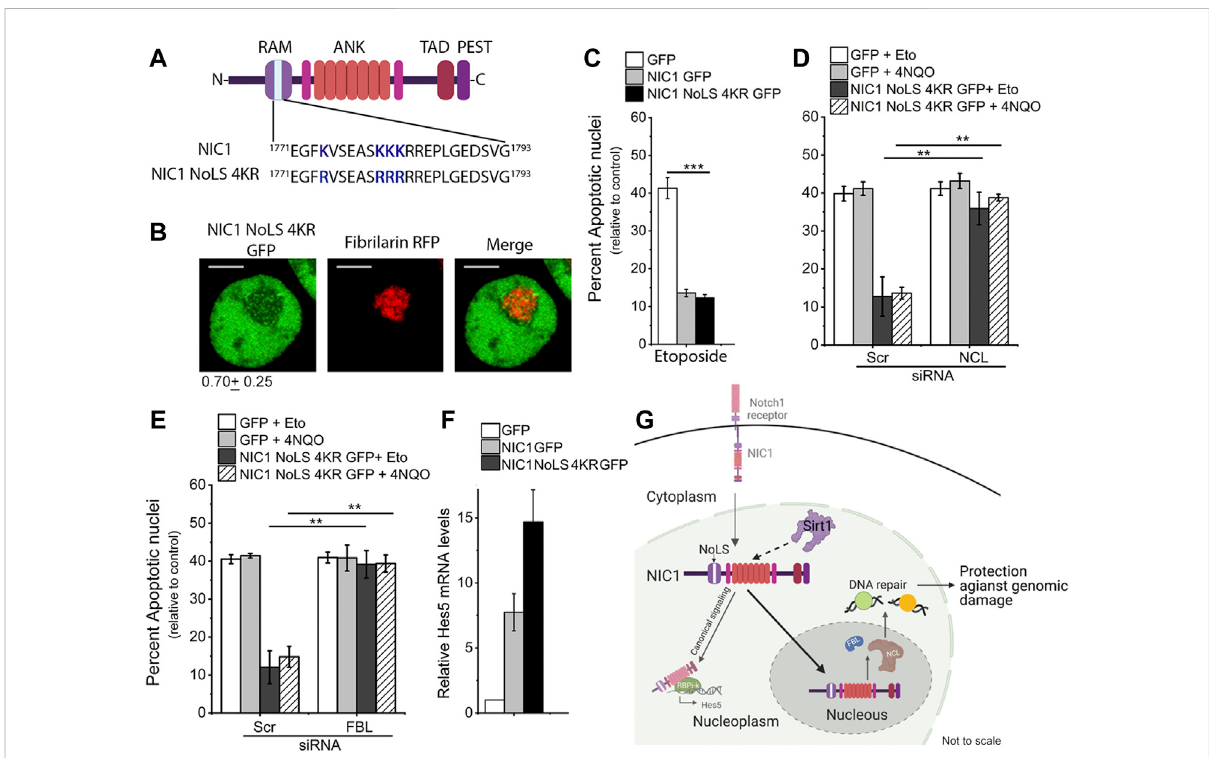
FIGURE 4 Lysine (K)to arginine (R)mutationinNIC1promoteslocalization to thenucleolus. (A) Schematicshowinglysine (K)residues mutated toarginine (R) in putative NoLS in NIC1. (B) Representative confocal images of HEK cells co-transfected with NIC1-NoLS 4KR-GFP and Fibrillarin-RFP and cultured for 24 h in complete medium before imaging. Images are representative of 50 cells across two independent experiments. Scale bar: 5 μ m. 0.79 ± 0.25 shows the relative NIC1-NoLS 4KR levels in the nucleolus as compared to the nucleoplasm. (C) Percent apoptotic damage in HEK cells expressing NIC1-GFP, NIC1-NoLS 4KR-GFP or GFP treated with etoposide (10 µM) for 48 h in medium containing 2% FBS. (D,E) Percent apoptotic damage in HEK cells expressing NIC1-GFP, NIC1-NoLS 4KR-GFP or GFP treated with etoposide (10 µM) or 4NQO (10 µM) for 48 h in medium containing 2% FBS. HEK cells pre-treated with siRNA to NCL (D) , FBL (E) , or scrambled control were transfected with plasmids and cultured for 24 hbeforeetoposideor4NQOtreatment. (F) Relative Hes5 mRNA expressioninHEK cells transfected with GFP, NIC1-GFP,or NIC1-NoLS 4KR- GFP and cultured for 30 h in the completed medium. (G) Schematic (not to scale) summarising the key outcomes. Sirt1 activity on lysine residues (K1774, K1780, K1781 and K1782) in putative NoLS promotes NIC1 localization to the nucleolus and induces dependence on nucleolar proteins for protection against genomic damage. Data plotted as mean ± S.D. of three independent experiments. *** and ** show signi fi cant difference